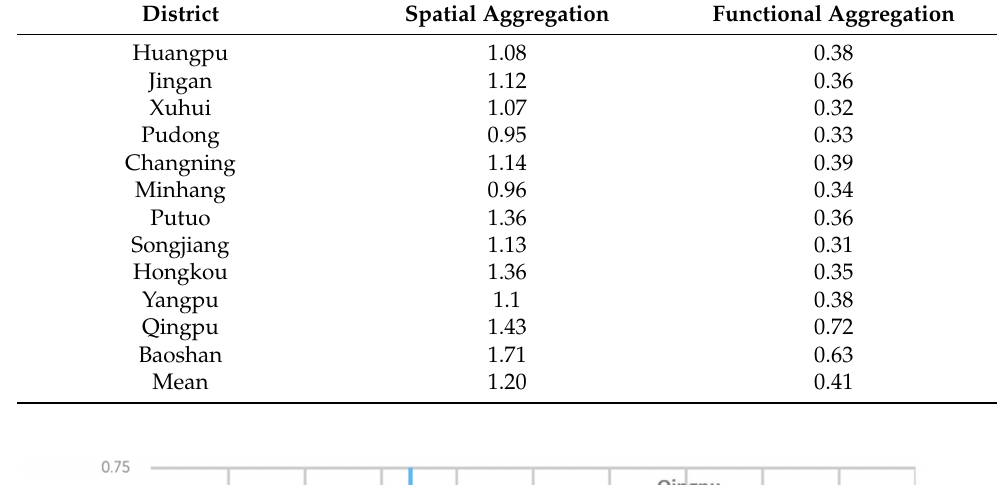
Table 4. Venues’ degree of spatial and functional aggregation per district.